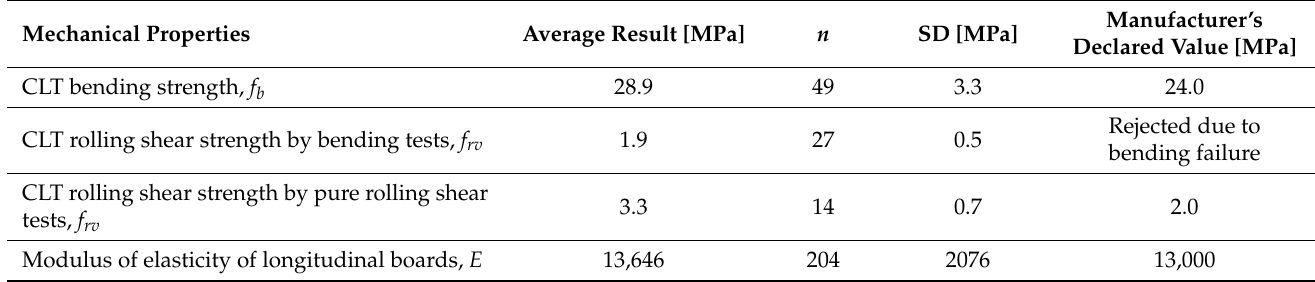
Table 3. Bending properties of the tested CLT panels.